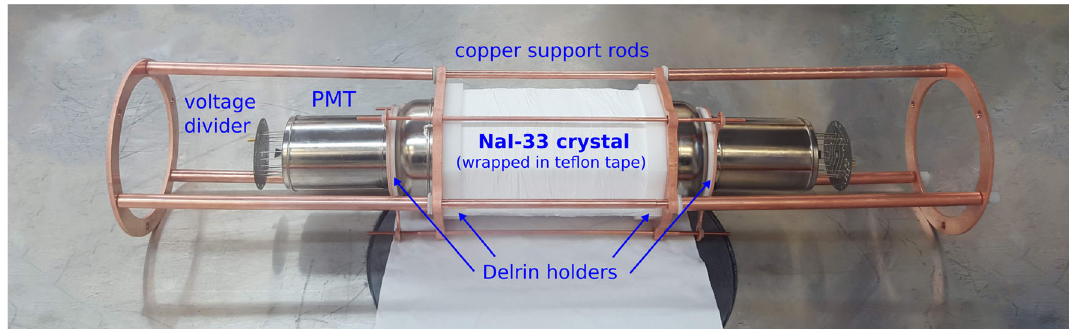
Fig. 1 NaI-33 assembly in the glovebox, ready for the insertion into the copper enclosure Fig. 2 Open passive shielding in the SABRE Hall B area. Left: Run 1 shielding. Right: Run 2 shielding with increased copper layer and detector module in position. The the anti-radon box is not shown here